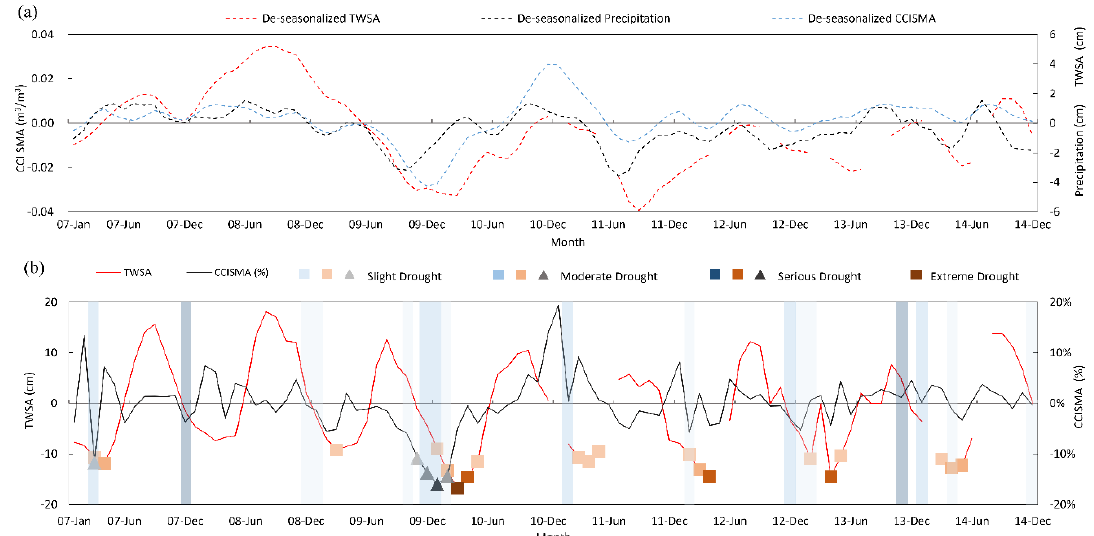
Figure 8. ( a ) Monthly average de-seasonalized and smoothed Total Water Storage Anomalies, Soil Moisture Anomalies, and precipitation anomalies, from 2007 to 2014, in Yunnan Province; ( b ) Drought grades were calculated by precipitation, Climate Change Initiative Soil Moisture (CCI SM), and Total Water Storage Anomalies (TWSA). The different blue bars represent the drought grades from precipitation. The month with no bar means non-drought. The red line represents TWSA and red squares represent the drought grades from TWSA. The gray line represents TWSA, and gray triangles represent the drought grades from CCI SM anomaly percentages.